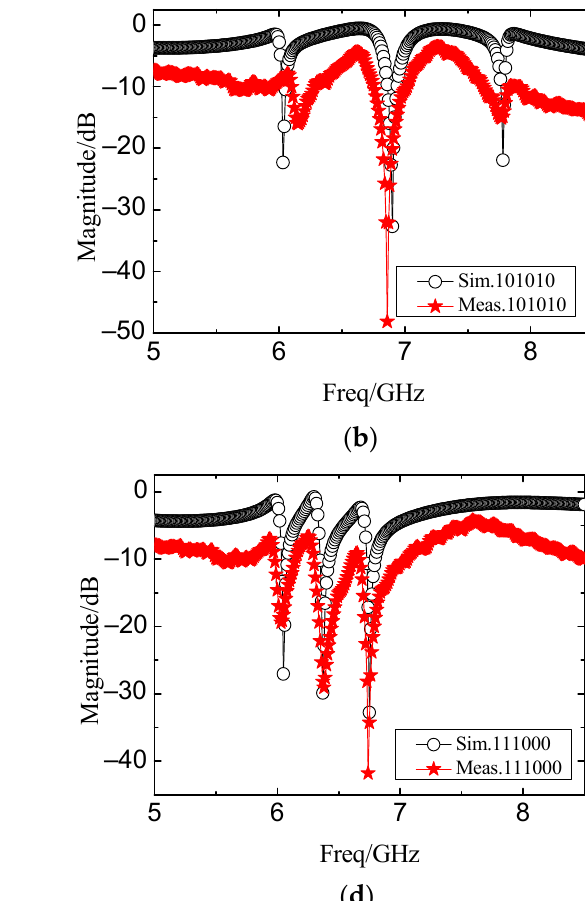
9 of 16 Figure 11. Current vector diagram of U-shaped slot resonator: ( a ) ID111111; ( b ) ID101010; ( c ) ID010101; ( d ) ID111000. The simulation and the measurement results of the 6-bit U-shaped slot resonators are shown in Figure 12. Figure 12a shows that the six U-shaped slot resonators corre- spond to six resonance points. The simulation and the measurement results are con- sistent. A 100 MHz frequency deviation appeared at the 5th resonance point. The value is within the allowable resonator bandwidth, so it does not affect the encoding state of the tag. Figure 12b–d show that, after removing the U-shaped slot, the corresponding simu-